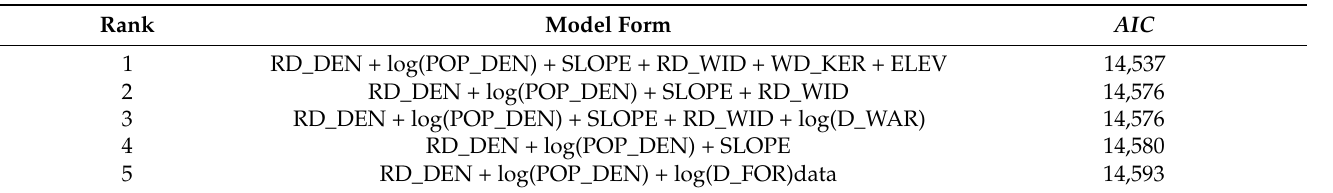
Table 3. Evaluated candidate models (top 5) for water deer roadkill. Variable notations are described in Table 1.